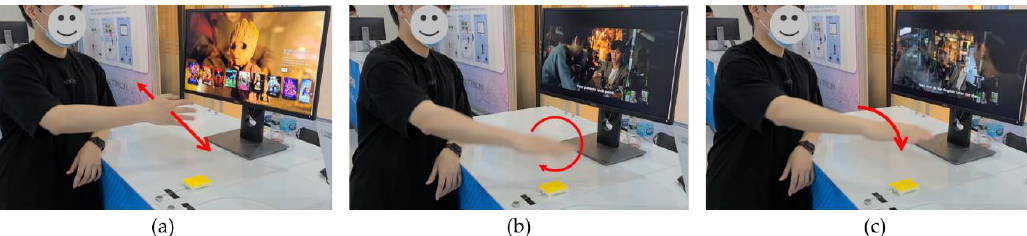
Figure 20. The over the top (OTT) control application based on the proposed gesture recognition system. ( a ) Swipe: scroll and forward / rewind; ( b ) clockwise rotation: go back; ( c ) push: play / system. ( a ) Swipe: scroll and forward/rewind; ( b ) clockwise rotation: go back; ( c ) push: play/stop.